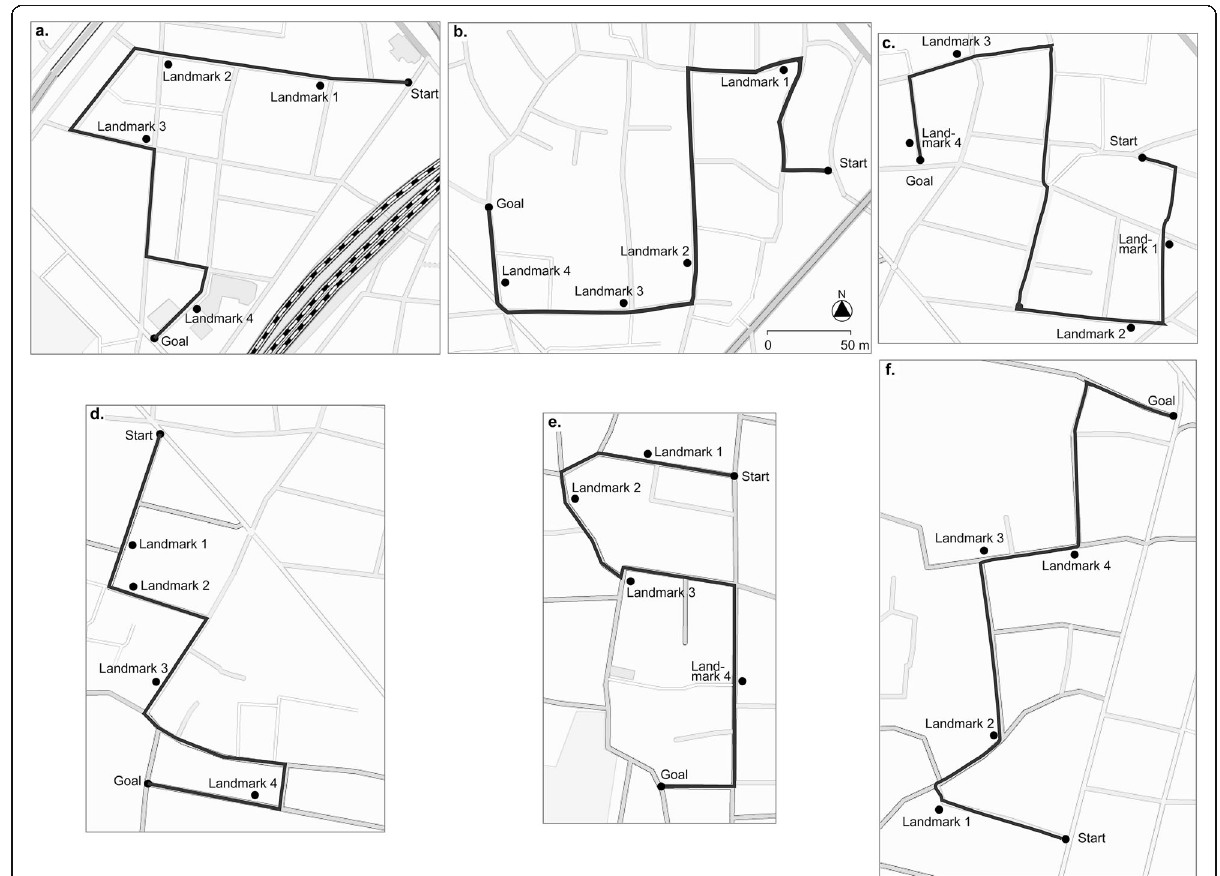
Fig. 1 Maps of the study routes. The routes were 450 m in length and contained five turns each. On each route, four landmarks were chosen that were easily recognizable and memorable. The six routes were assigned to the 6 sessions randomly (routes a – f to sessions 1 – 6). Participants walked one route in each session and conducted spatial tasks designed to assess their knowledge of the route. The scale bar and north arrow apply to all panels. © OpenStreetMap contributors.